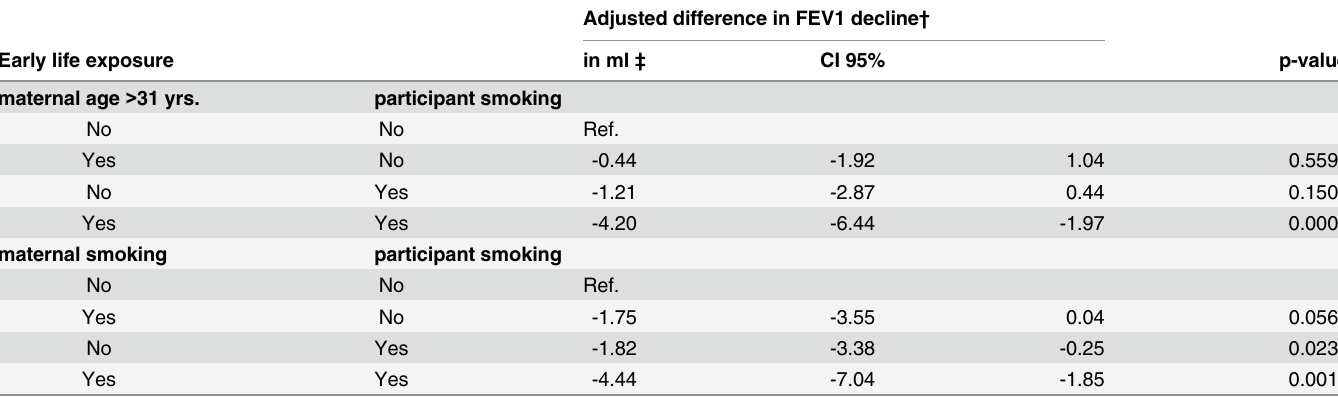
Table 4. Synergistic effects of early life factors and participants ’ current smoking status with regard to lung function